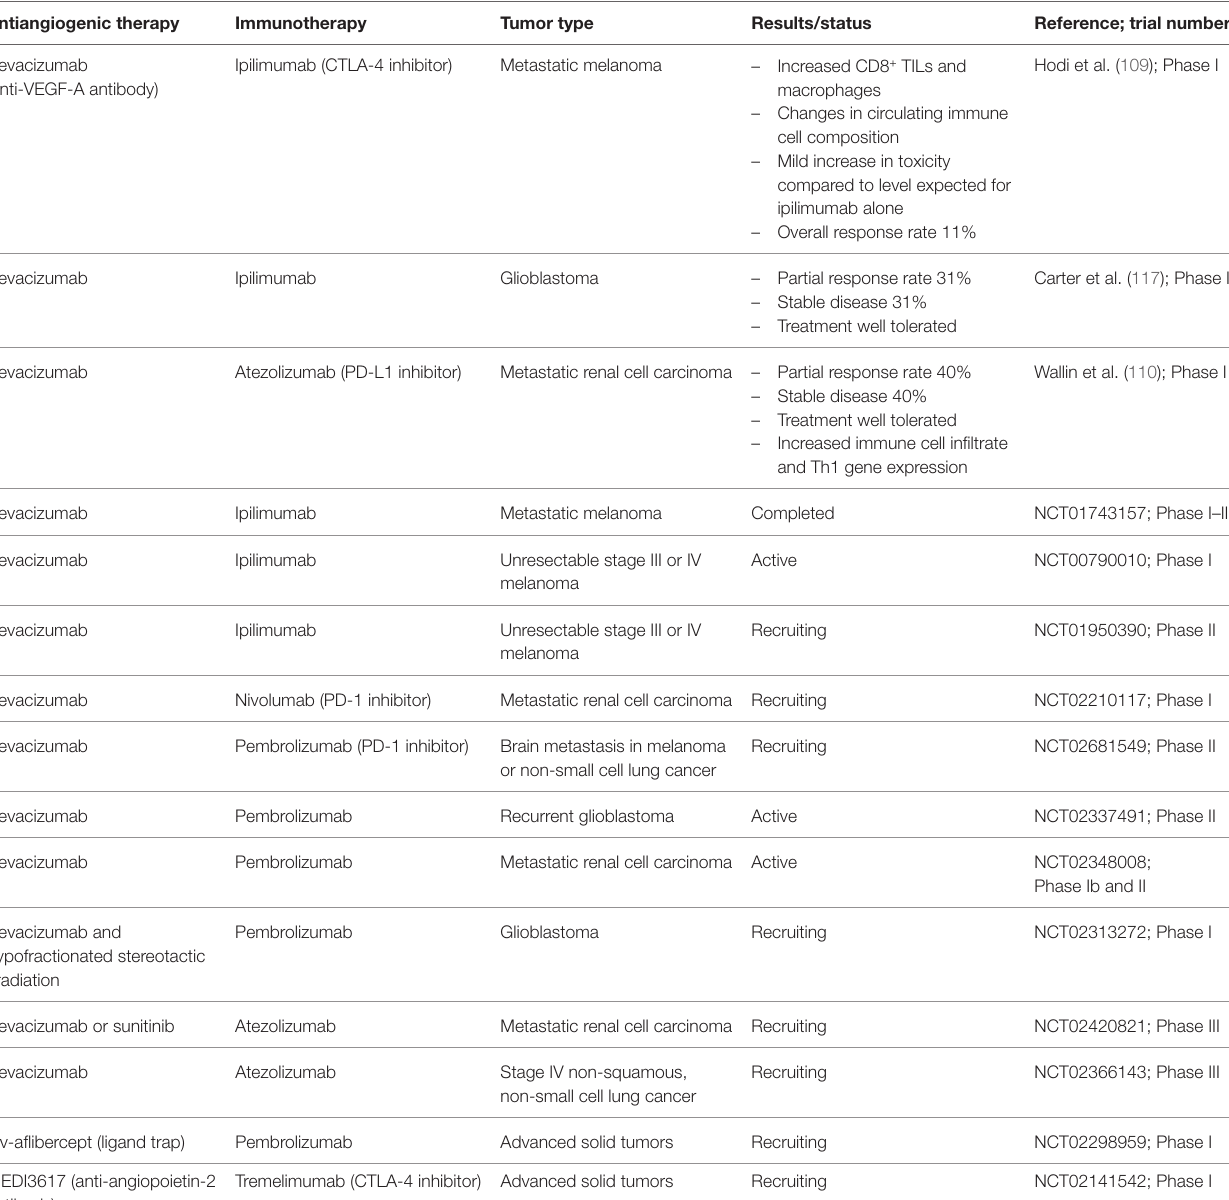
TABLe 2 | Summary of published and ongoing clinical trials combining antiangiogenic therapies and